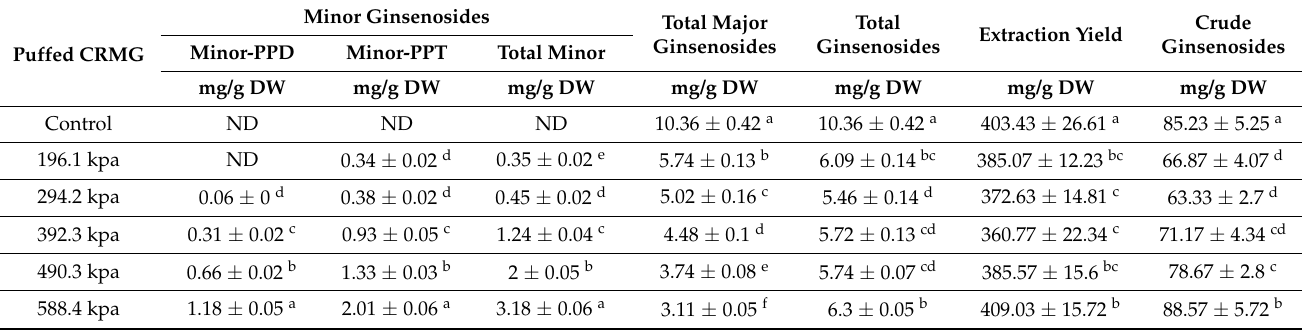
Table 1. Contents of ginsenosides and extraction yield of puffed CRMG (mg/g) by increasing pressure.